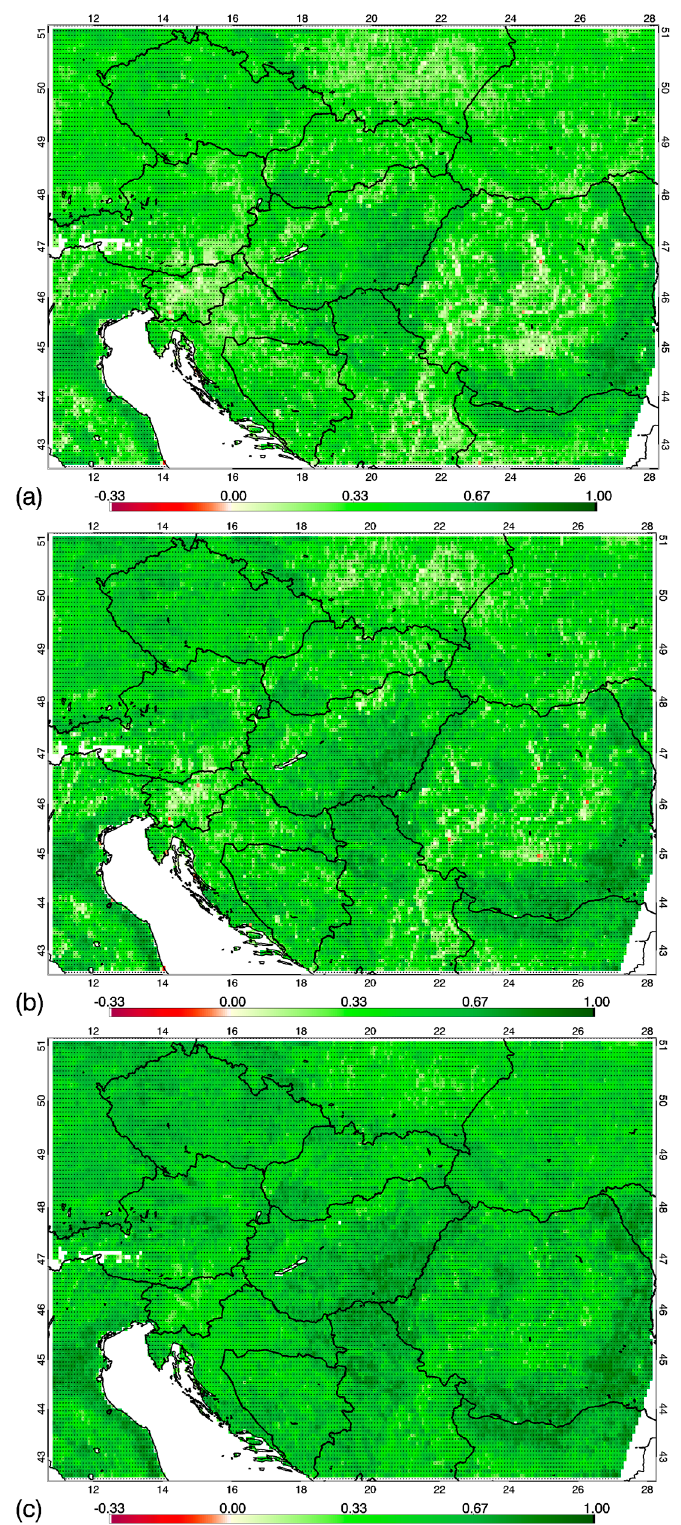
Figure 6. Map of R values between the anomalies derived from Terra/NDVI MODIS and ( a ) NDVI3g O , ( b ) NDVI3g F and ( c ) NDVI3g H datasets during the overlapping 14 years taking into account only the time period between the second half of April and the first part of September period. Pixels with dots inside indicate statistically significant R (p < 0.01).